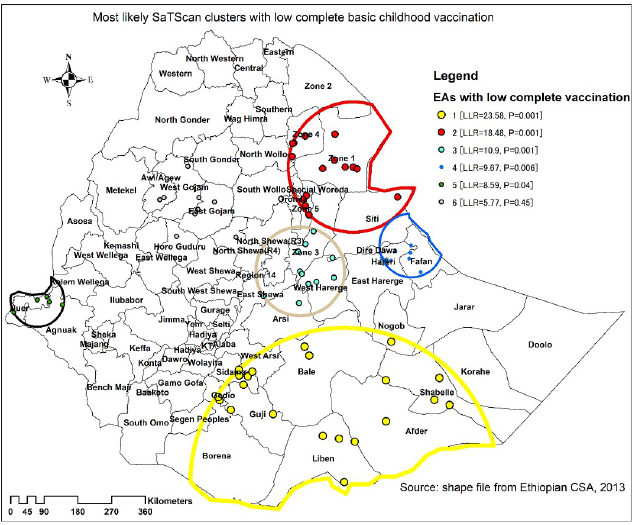
Fig 4. Spatial scan analysis of complete basic childhood vaccination among children aged 12–23 months in